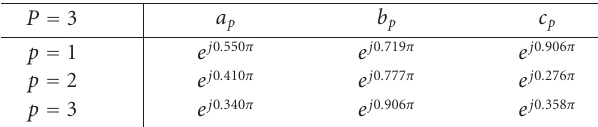
Table 1: Generators of the 3D harmonics used for simulation with synthetic data in Section